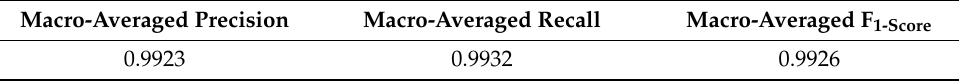
Table 4. Additional evaluation metrics for the ViT trained model.